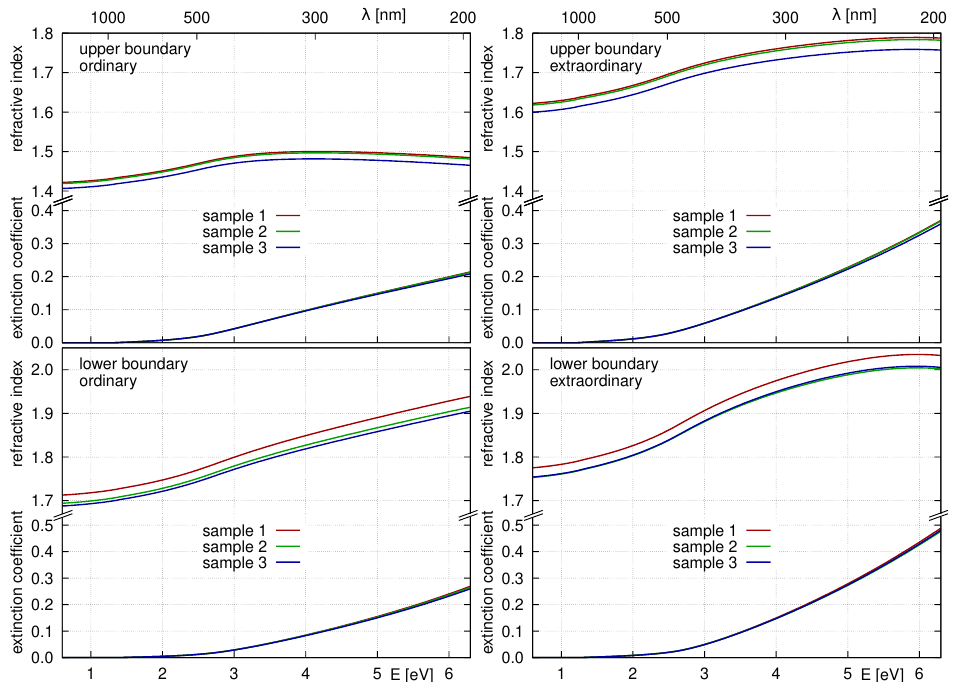
Figure 10. Spectral dependencies ofthe optical constants of the SiN x film at the upper ( top ) and lower ( bottom ) boundaries for the ordinary ( left ) and extraordinary ( right ) waves.